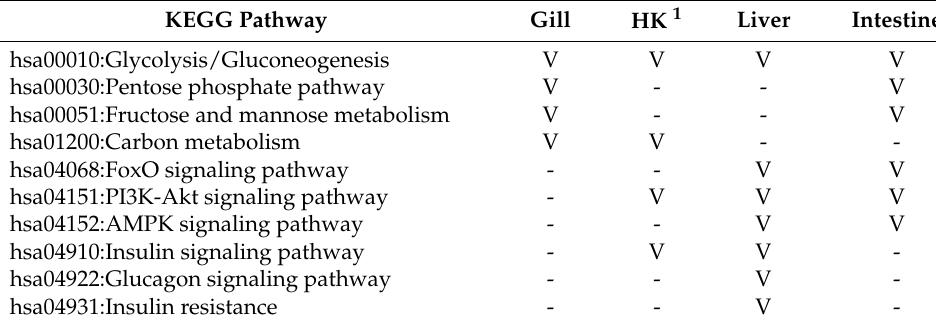
Table 5. Energy-related metabolism pathways enriched in common carp. KEGG